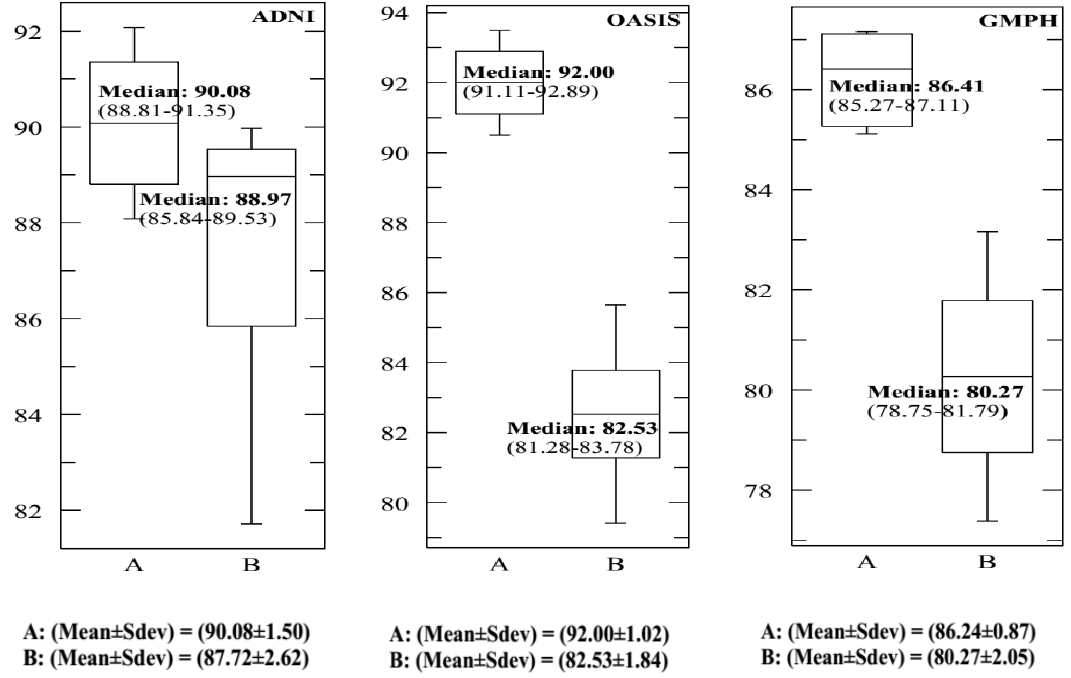
Figure 16. The corresponding Box-and-whisker plots of the descriptive statistics of the sensitivity (SE) values for ADNI, OASIS and GMPH datasets with 20% additive noise, using 10-fold cross validation to evaluate the proposed SVDD classifier based on BCFCM/GA/PFCM segmentation approach (case A in figure). Comparison with SVM classifier, based on BCFCM/GA/PFCM (case B ).